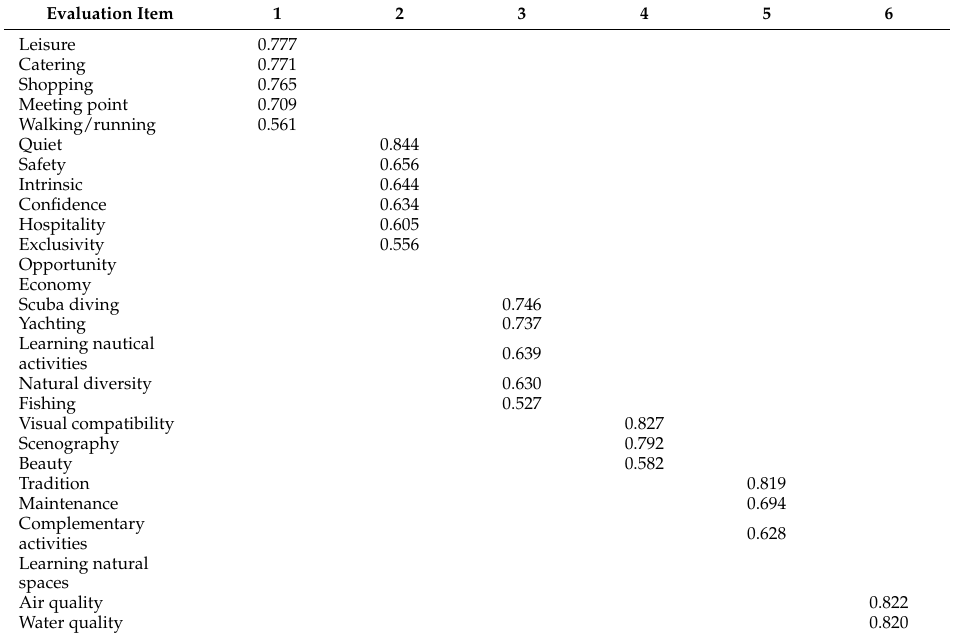
Table 5. Component matrix after rotation